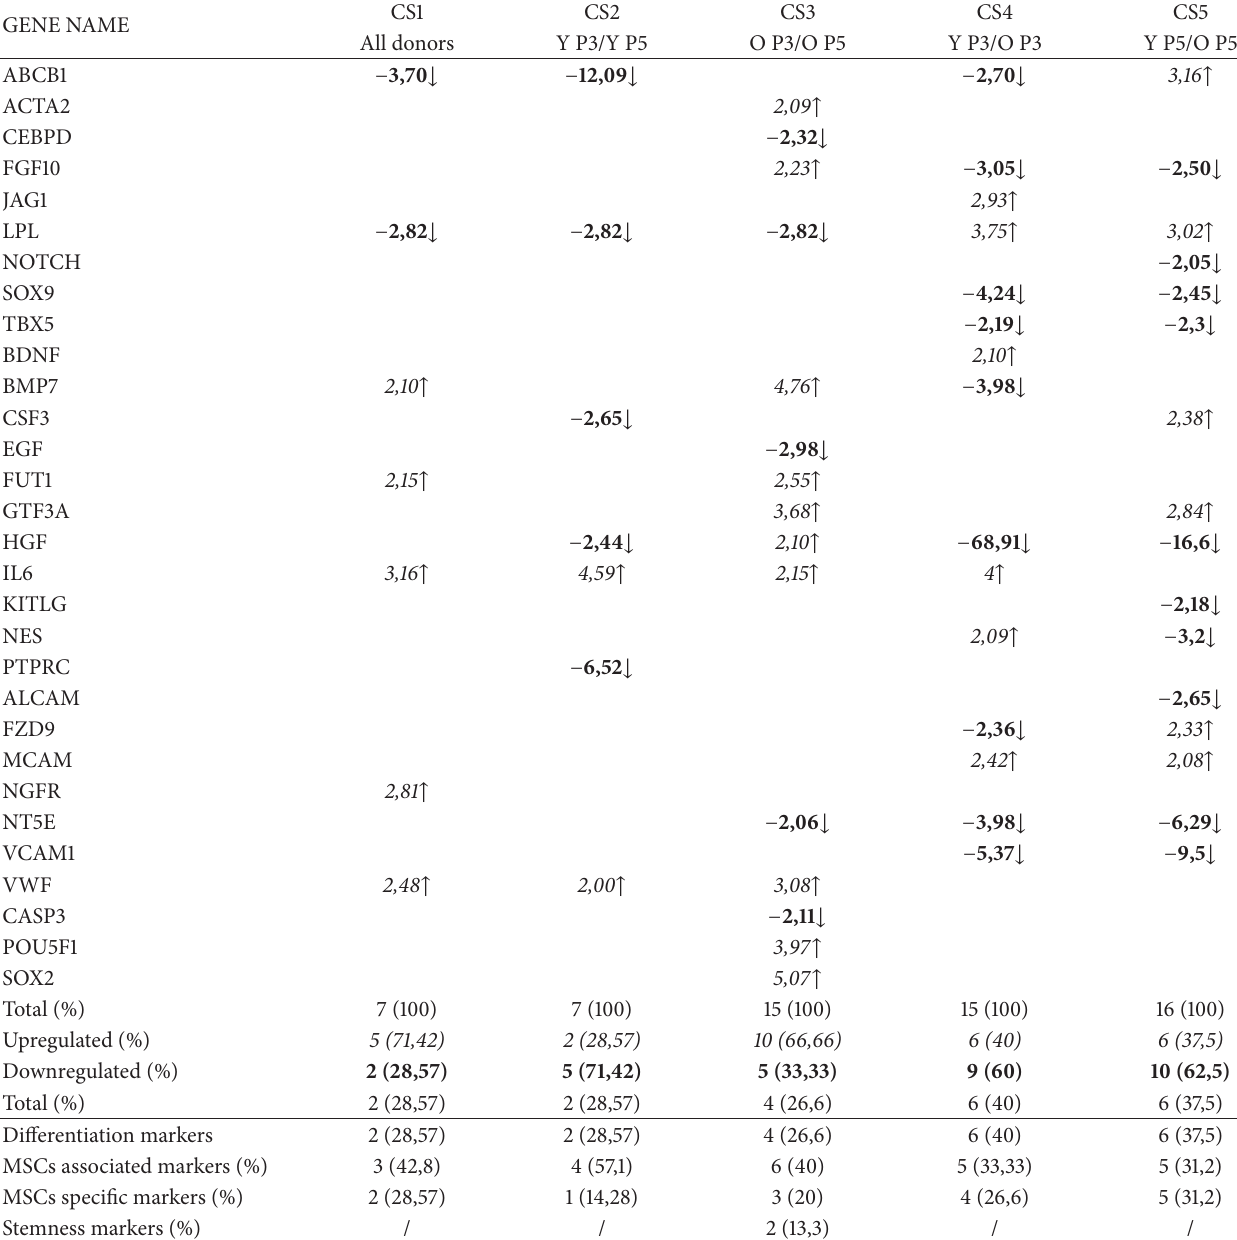
Table 2: Results of relative gene expression analysis. Summary of all results in different comparison set